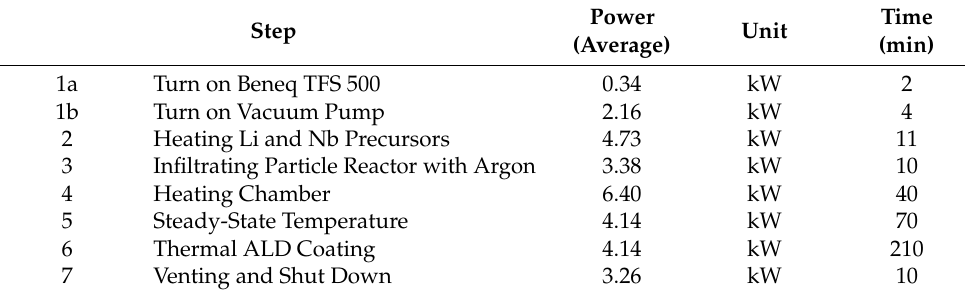
Table 2. Stepwise Average Power Consumption for ALD Process.